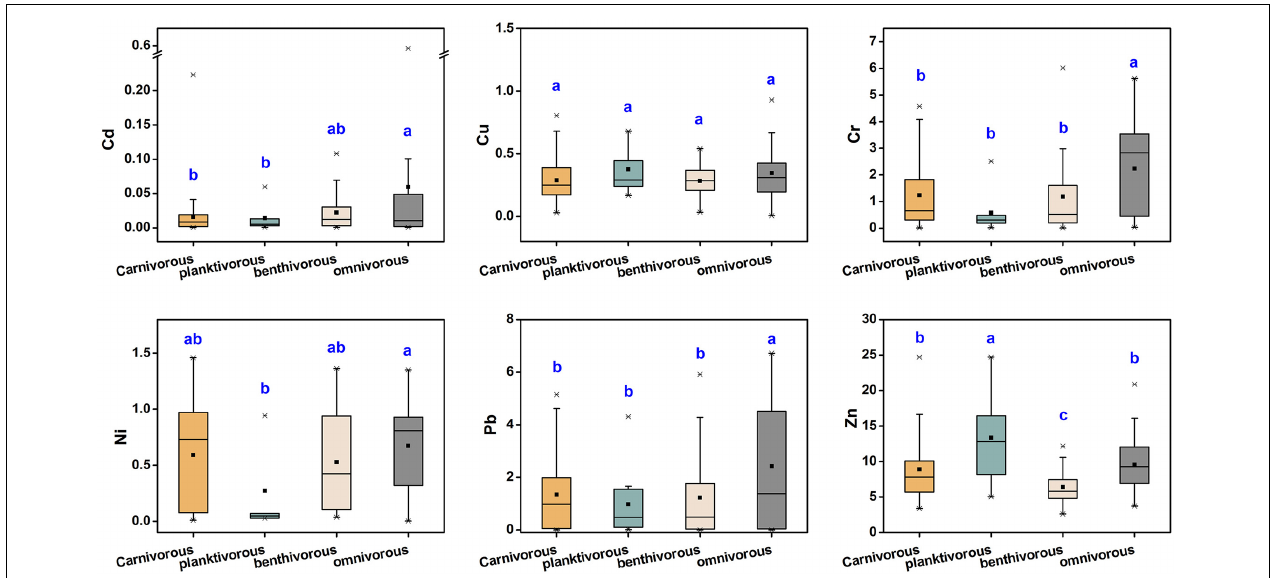
FIGURE 4 | The difference of trace metal concentrations ( µ g/g, w.w.) in marine muscle tissue with different feeding